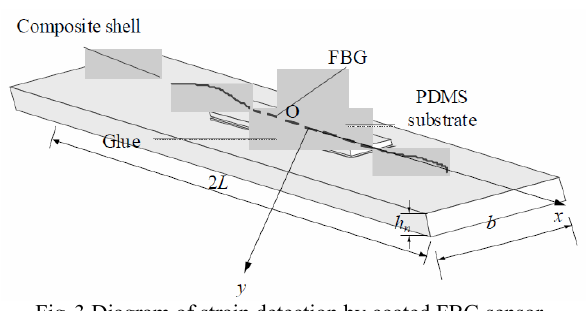
Fig. 3 Diagram of strain detection by coated FBG sensor.